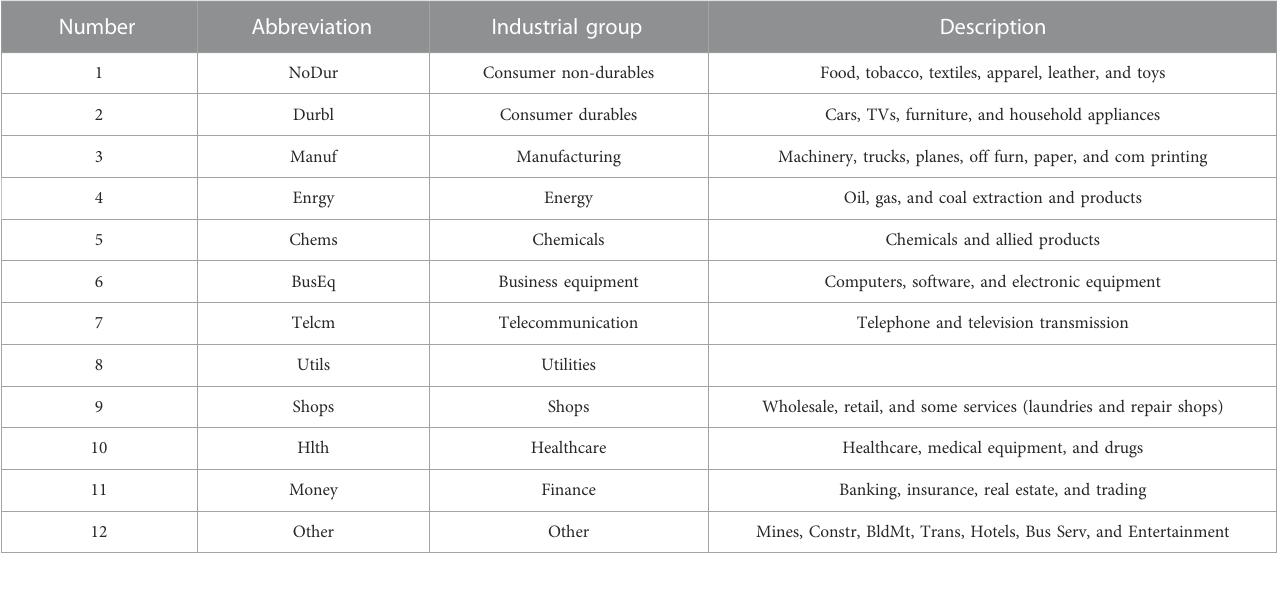
TABLE 1 Groups based on Standard Industrial Classi fi cation (SIC). We downloaded SIC codes from the Fama – French website to divide sample fi rms into 12 industry groups.